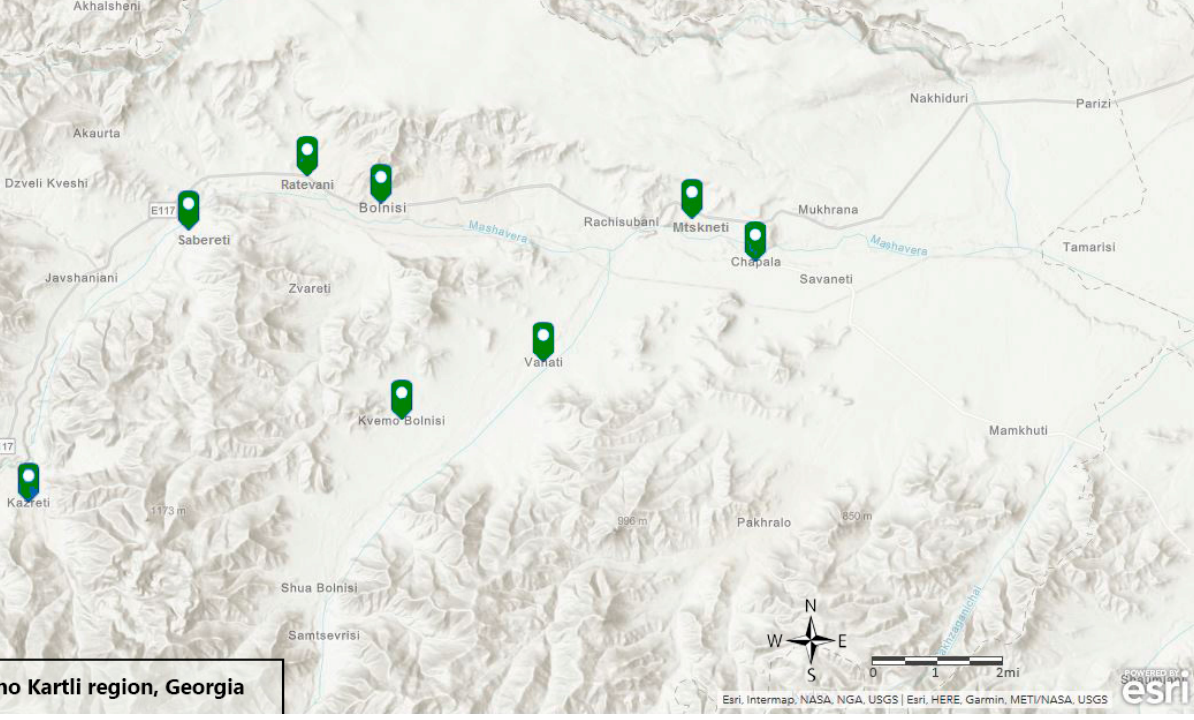
Figure 1. Map of the study area (Authors’ illustration). The sampling sites are located in villages adjacent to the Mashavera river or one of its sub-channels proven to be contaminated with heavy metal. The sampling protocols of milk, Imeruli cheese and Sulguni cheese were analyzed to reveal these elements: Cd, Pb, Cr, Cu, Fe, Mn, Se, Zn, Co, Ni,